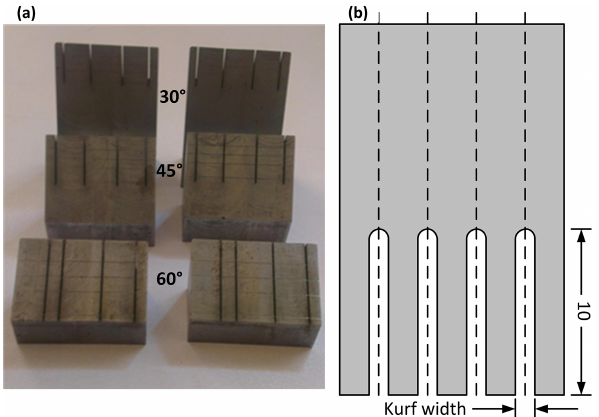
Figure 3. Titanium alloy workpieces cut with 30, 45, 60 ◦ tapper angle. (a) Cut workpieces, (b) Dimensions of slots.